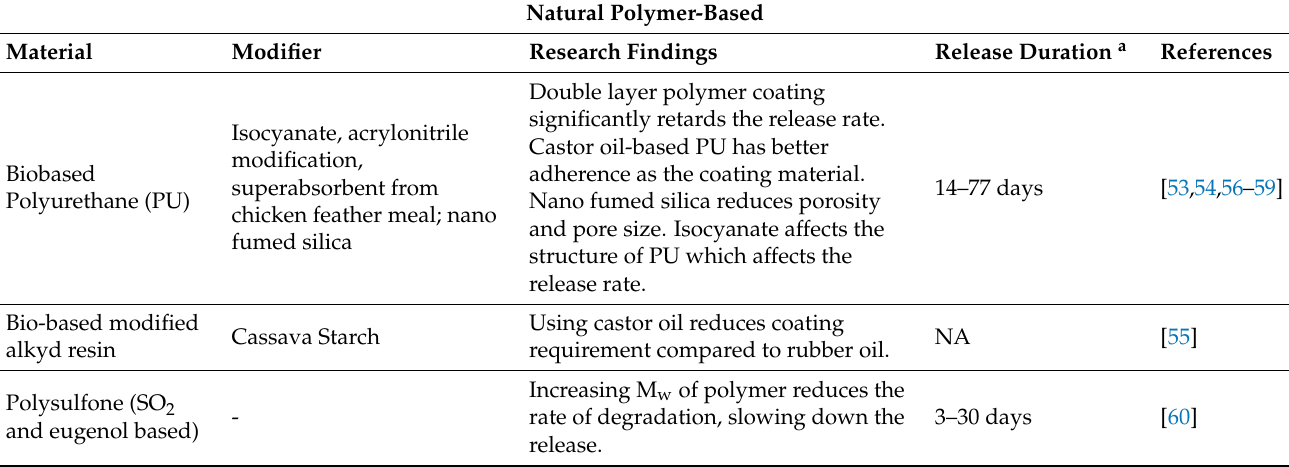
Table 3. Natural polymer based